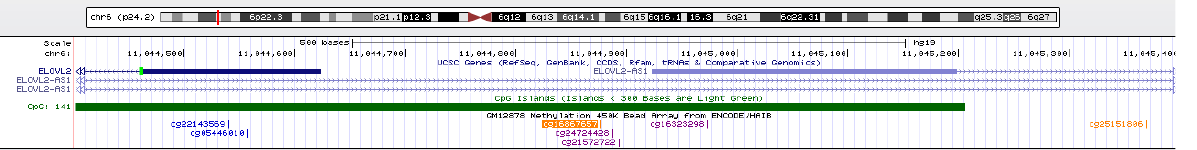
Figure 6. UCSC genome browser view of the genomic location of the CpG cg16867657.